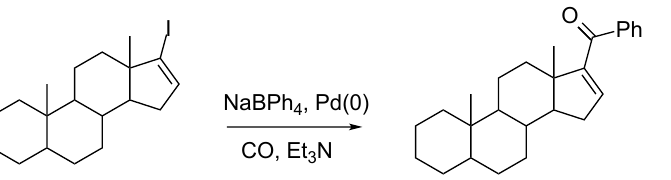
Figure 13. Pd-catalyzed carbonylation of 17-iodo-androst-16-ene in the presence of NaBPh 4 . Hydroxamic acid derivatives were synthesized from 17-iodo-androst-16-ene based sub- strates. Depending on the substrate both O-acylation and N-acylation took place; O-methyl- hydroxylamine afforded the 17-(N-methoxy-carbamoyl) structures, acetohydroxamic acid led to O-acylation exclusively, whereas the carbonylation of N-methyl-hydroxylamine resulted in both the O-acylated and the N-acylated products (Figure 14) [68].